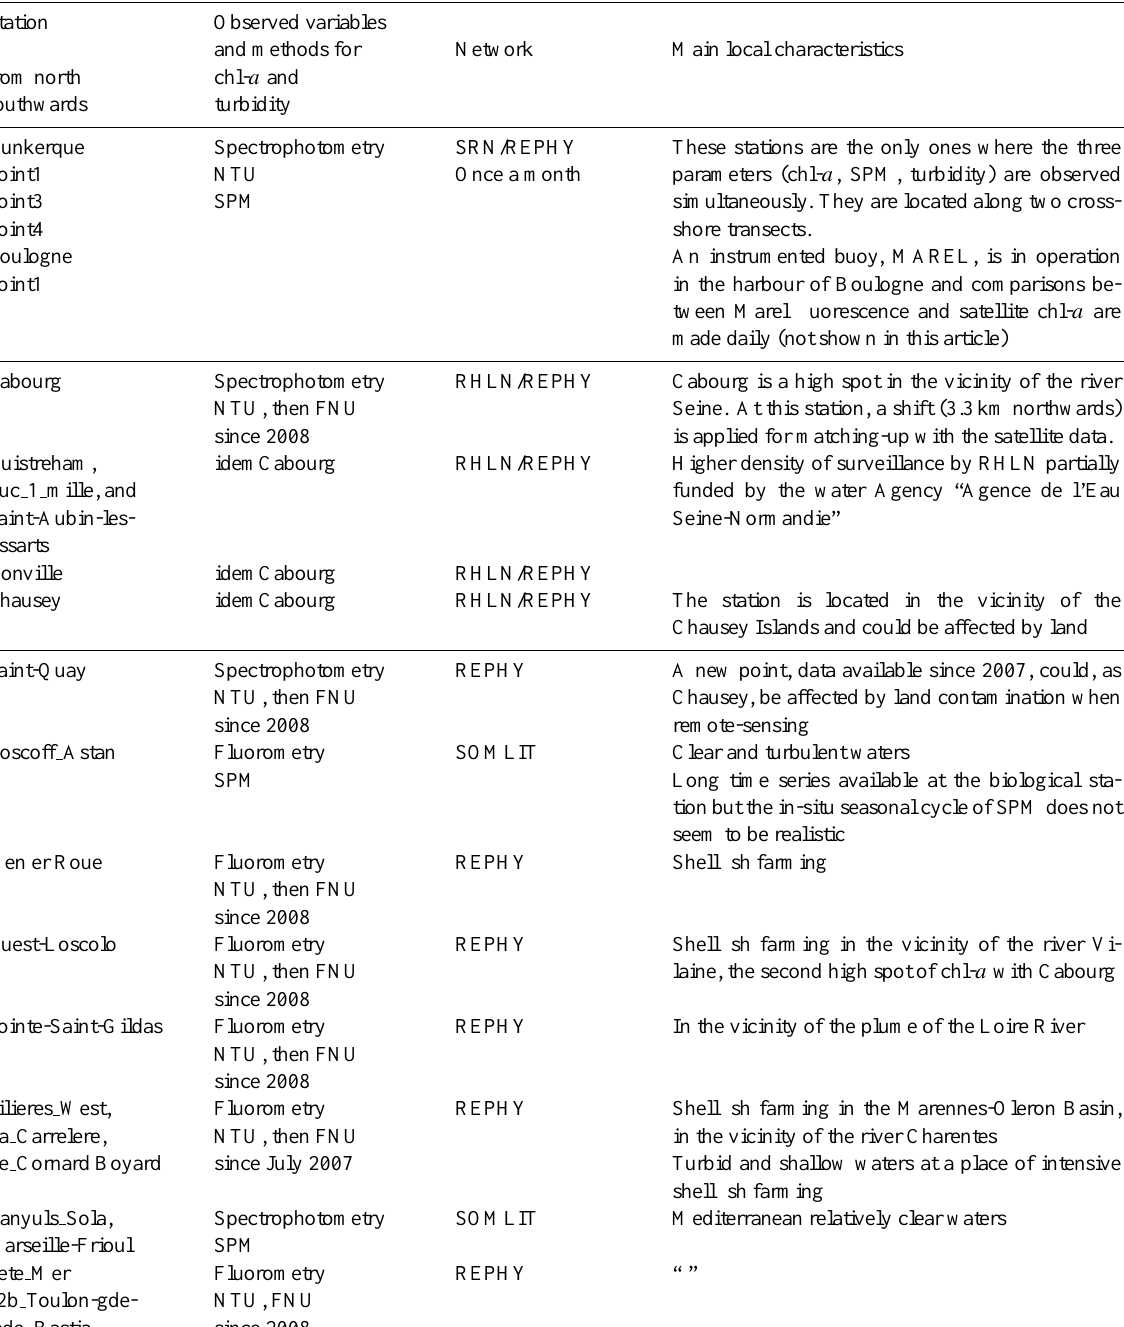
Table 1. The 26 selected stations and their mean characteristics. Positions of the stations are indicated in Fig. 1. Water is sampled between the surface and one metre depth. Frequency is twice a month for the REPHY and RHLN during the productive season (March to